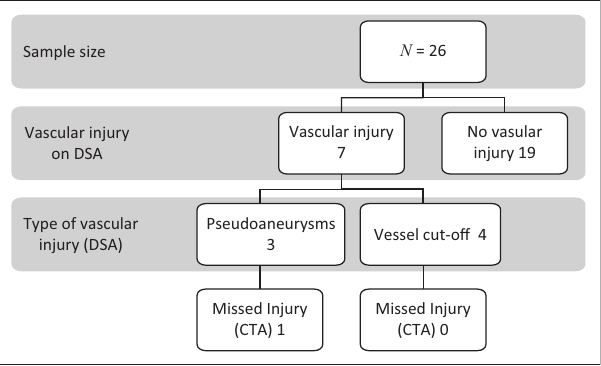
FIGURE 3: Flow-chart summarising patient distribution with regards to diagnosis of vascular injury by digital subtraction